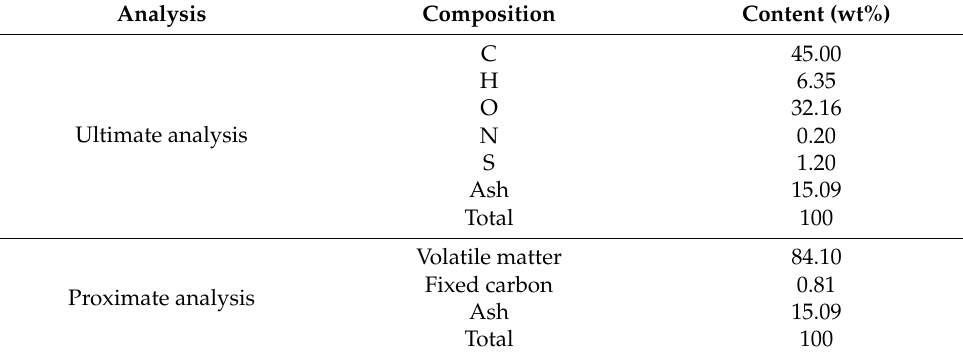
Table 1. Results of proximate and ultimate analyses of DJW (dry basis).